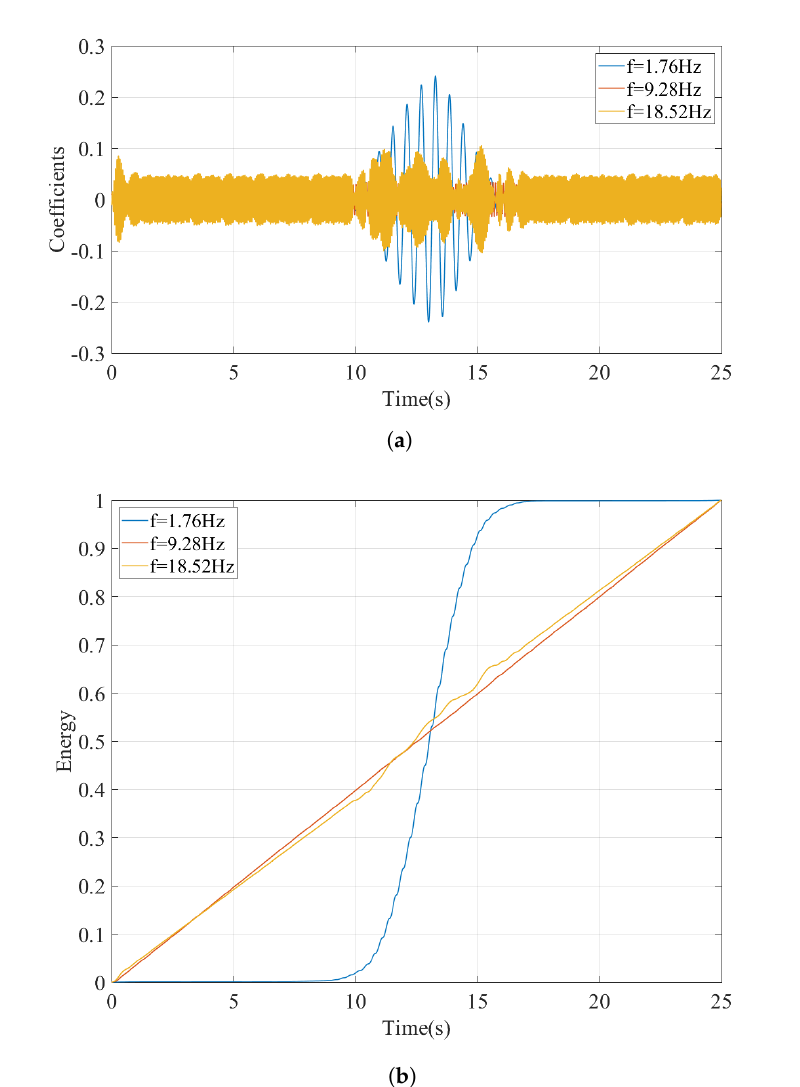
Figure 13. Regular track at a speed of 20 km/h. ( a ) Coefficients from CWT of the acceleration signal at different pseudo-frequencies. ( b ) Development of the energy in the coefficients at different